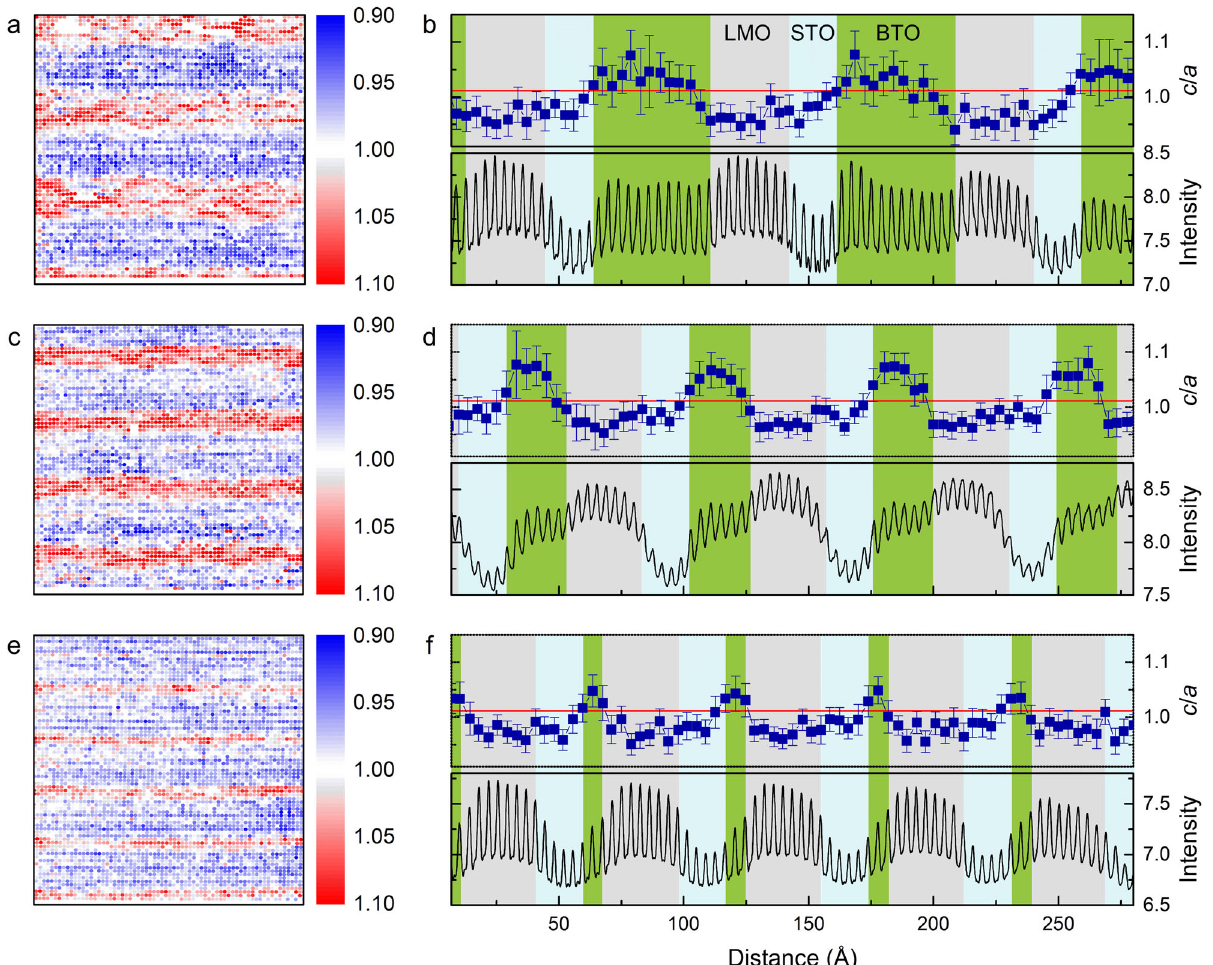
Fig. 3 STEM mapping of tetragonality ( c / a ). Two-dimensional mapping of c / a for L 8 B 12 S 5 ( a ), L 8 B 6 S 5 ( c ) and L 8 B 2 S 5 ( e ). The corresponding c / a averaged within each atomic layer is plotted in ( b ), ( d ) and ( f ), respectively. The error bars show the standard deviation for each atomic plane. In ( b ), ( d ) and ( f ), the red line in upper panels indicates the c / a value of BTO single crystal, and the bottom panels show the HAADF intensity in arbitrary units for ease of identifying each